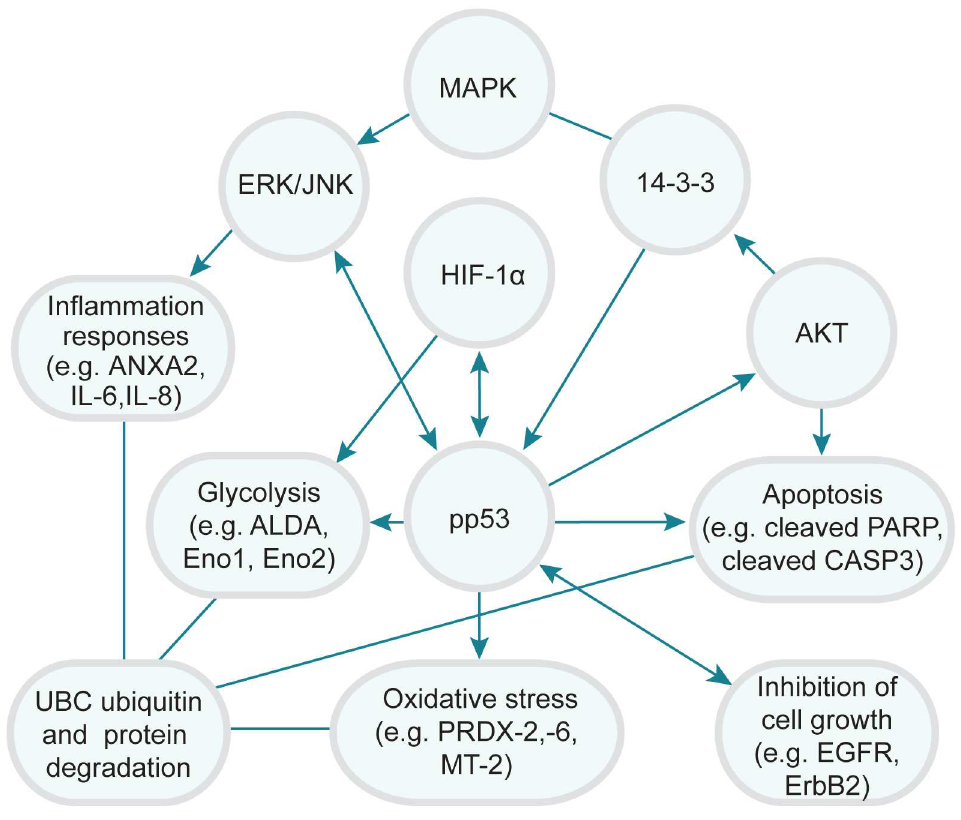
Fig 6. Schematic representationof the interplayof the core proteinsand cytotoxicity pathways mediatedby Ni (II). Key proteinsor pathways that were likely to play criticalroles in determining sensitivityor cytotoxic responseof BES-2B cells to Ni (II)treatmentsare shown